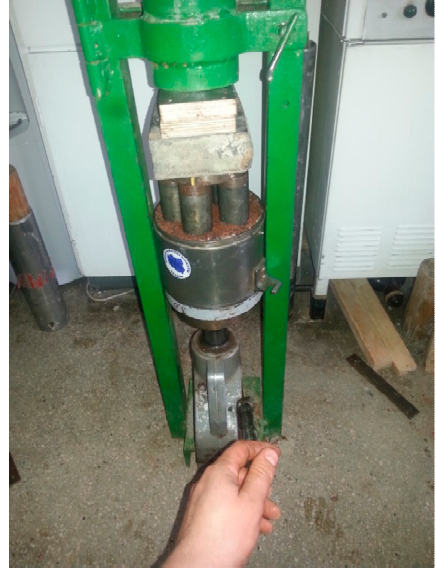
Figure 2. Preparation of specimens from the Red Clay-Rubber (RCR) mixture.